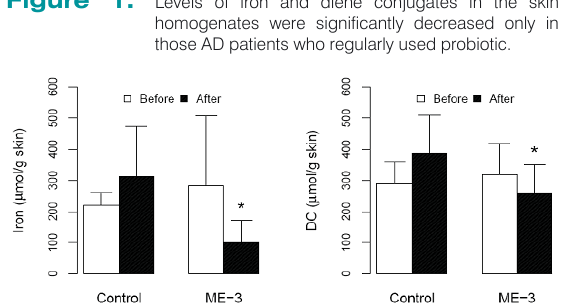
Figure 1. Levels of iron and diene conjugates in the skin homogenates were significantly decreased only in those AD patients who regularly used probiotic.